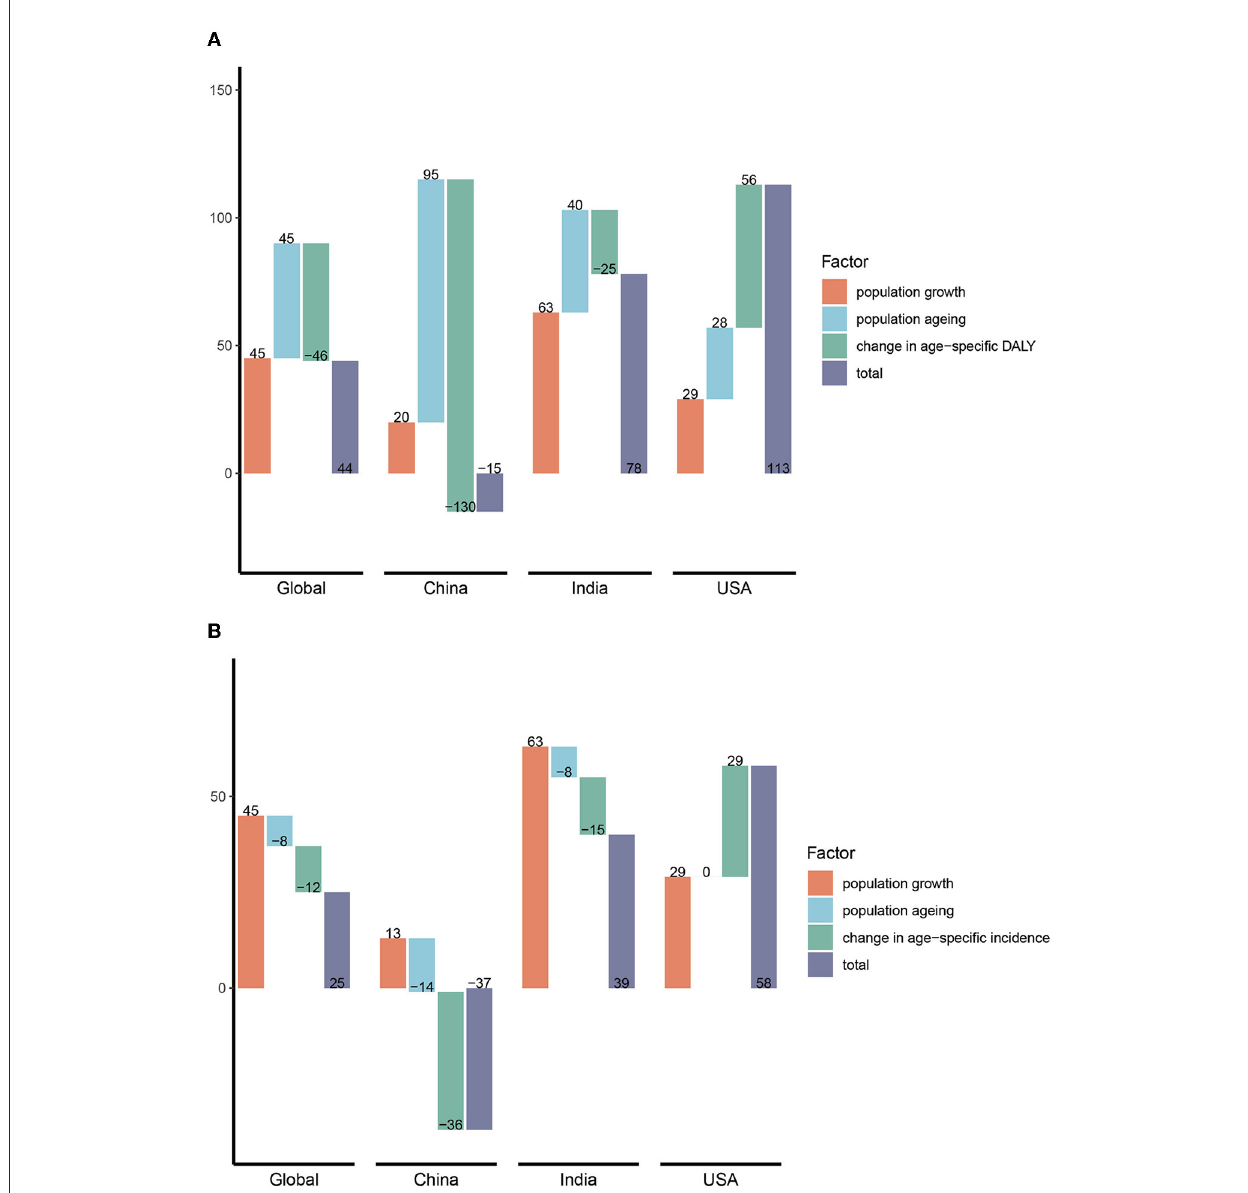
FIGURE9 Decomposition of changes (%) in DALY and incidence of HCV in different regions. (A) DALY; (B) incidence. DALY, disability-adjusted life years.